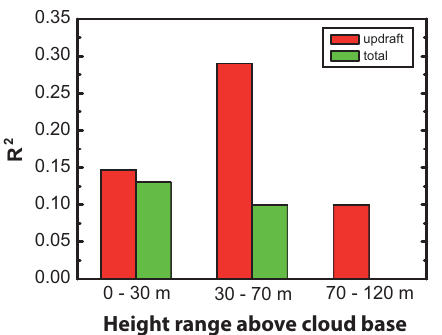
Figure 6. Coefficient of determination R 2 in the case of linear re- gression of aerosol proxy and CDNC to obtain ACI N as shown in Figs. 3 and 4. The green bars show R 2 when vertical wind informa- tion is ignored. The red bars are obtained when data only for updraft periods are considered in the linear